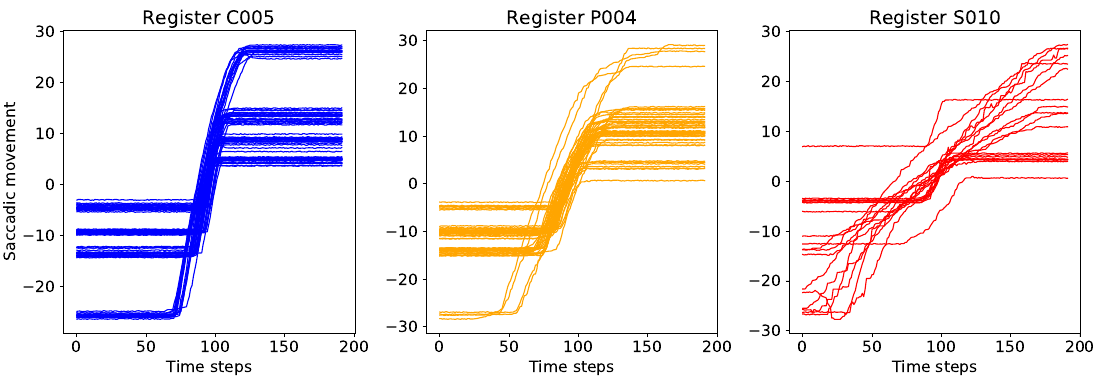
Figure 1. Examples of 3 random registers used for training: from left to right , for control, presymptomatic and sick.